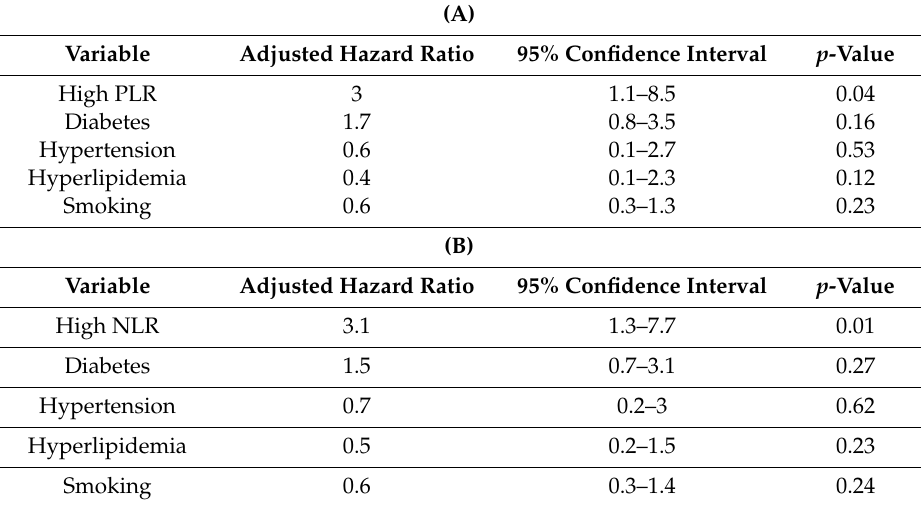
Table 3. Adjusted hazard ratios, 95% confidence intervals, and p -values of multivariable Cox regression